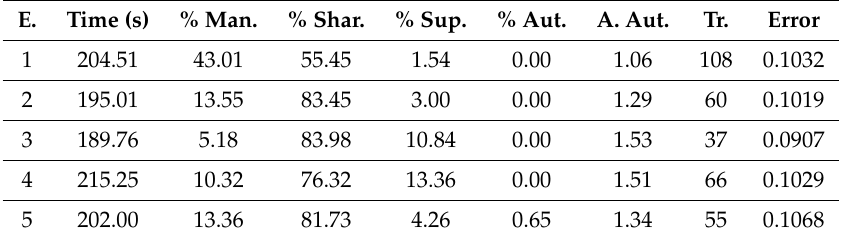
Table 9. Sliding Autonomy